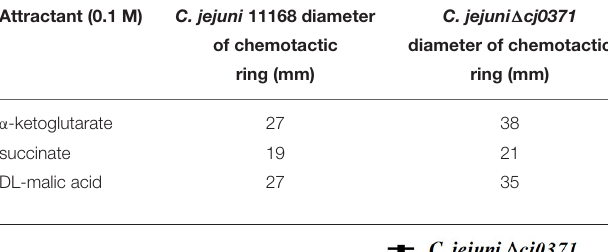
TABLE 3 | The diameters of chemotactic rings with different attractants. Attractant (0.1 M)